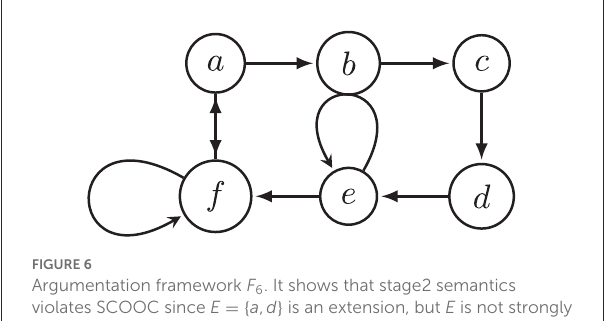
FIGURE6 Argumentation framework F 6 . It shows that stage2 semantics violates SCOOC since E = { a , d } is an extension, but E is not strongly complete outside odd cycles: b and c are not in an odd cycle, { c } − = { b } , but E does not contain c